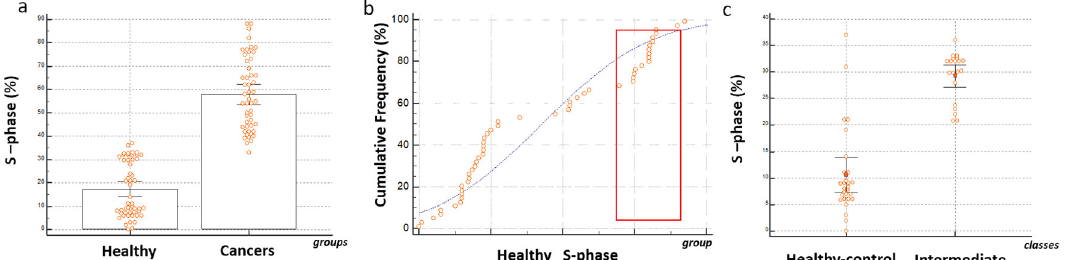
Figure 3. Proliferation rate in Blood-derived cultures. ( a ) Each orange dot plots correspond to individual blood-derived cultures data. Comparative independent sample t-test between the percentages of cultured cells in S phase in control and cancer blood-derived cultures. p ≤ 0.0001; ( b ) cumulative frequency distribution of percentage of S phase in the control group. The blue line shows the trend in observed distribution of S-phase percentage values. The orange frame indicates the range of S phase values characterizing the intermediate class individuate through protonation measurement. In ( c ) independent sample test reports a significant difference p ≤ 0.0001 between the two classes of samples belonging to healthy group in order of percentage of cells in S-phase at 14 days of culture.